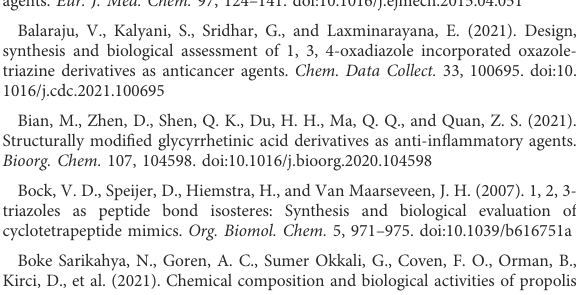
Figure creation — HD, L-JJ, and C-FE. Revision — J-LL, Q-KS and Z-SQ. All authors have read and agreed to the published version of the